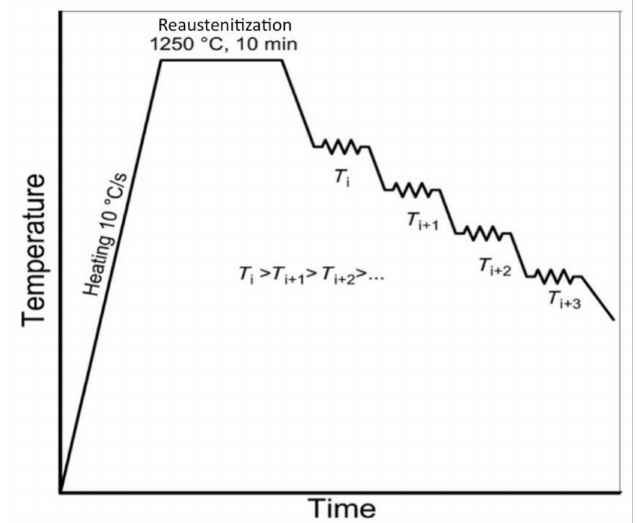
Figure 2. Schematic diagram of heating and cooling curve used in gleeble for compression